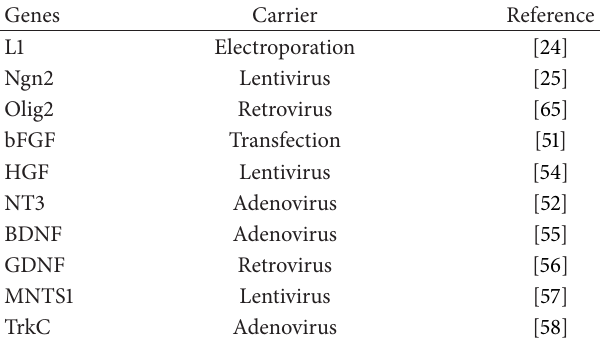
Table 7: Genes used for engineering